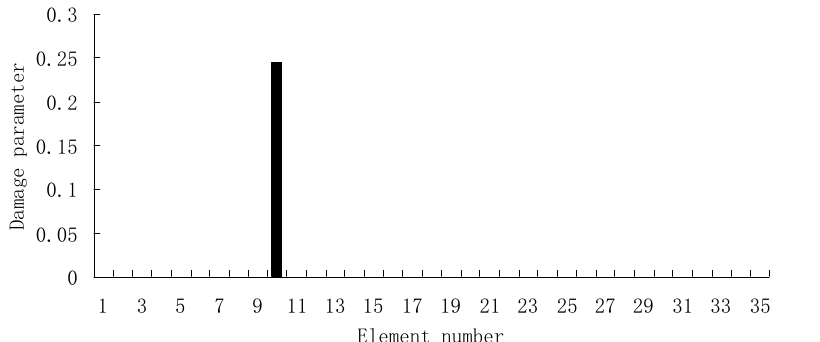
Figure 7. Damage evaluation result by the fourth computation of ESVT for case 1 (element 10 had 20% stiffness reduction).